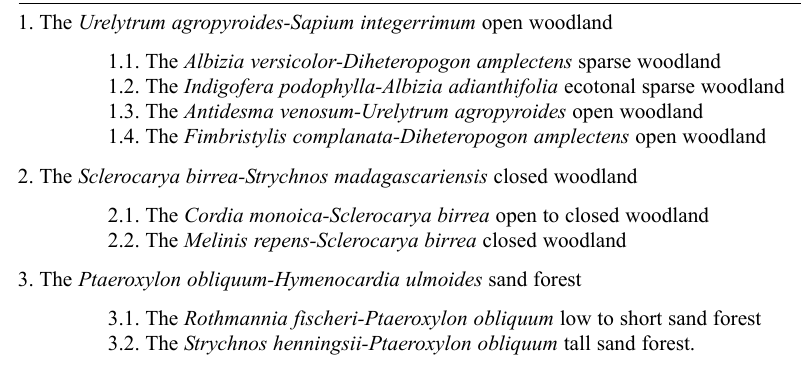
Classification of the vegetation communities for Tshanini Game Reserve in northern KwaZulu-Natal, South